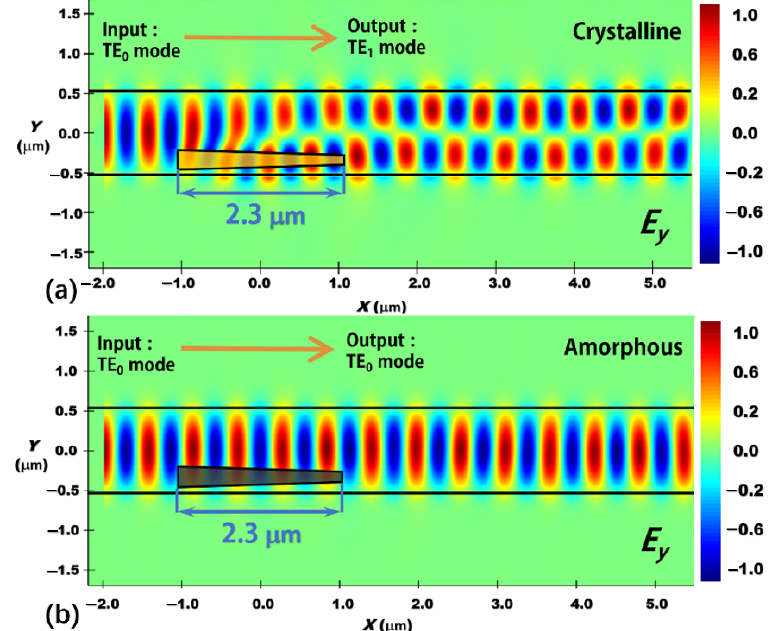
Figure 9. Evolutions of the electric field (dominant component: E y ) along the propagation direction ( x -direction) through the proposed mode converter. ( a ) Sb 2 Se 3 layer working at the crystalline state and ( b ) Sb 2 Se 3 layer working at the amorphous state. The mode conversion length is 2.3 μm and the working wavelength is 1.55 μm.